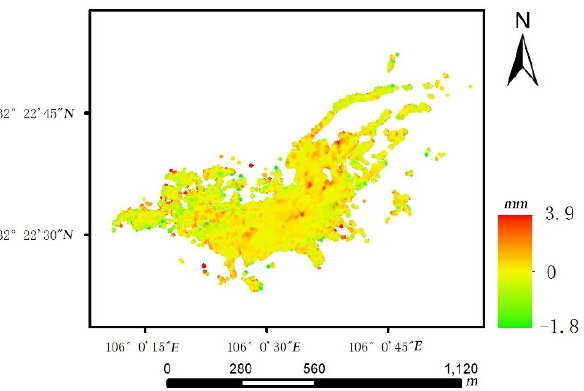
Figure 14. Histogram of residuals at 10/30 00:09.